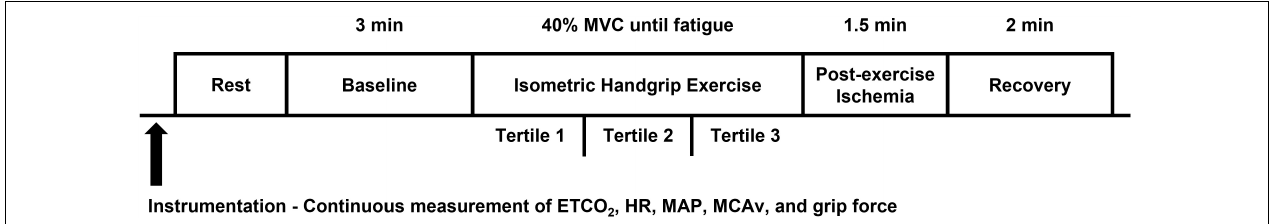
FIGURE 1 | Experimental study day timeline. ETCO 2 , end-tidal CO 2 ; HR, heart rate; MAP, mean arterial pressure; MCAv, middle cerebral artery blood velocity.